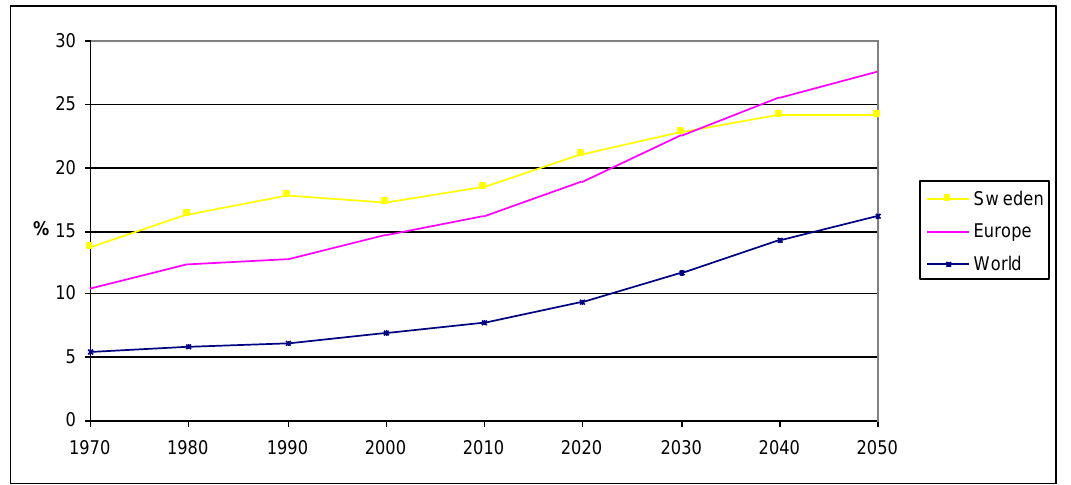
Figure 1. Historical, current and projected proportions (percent) of Swedish, European and global populations aged 65 years or more. Source: UN medium fertility variant